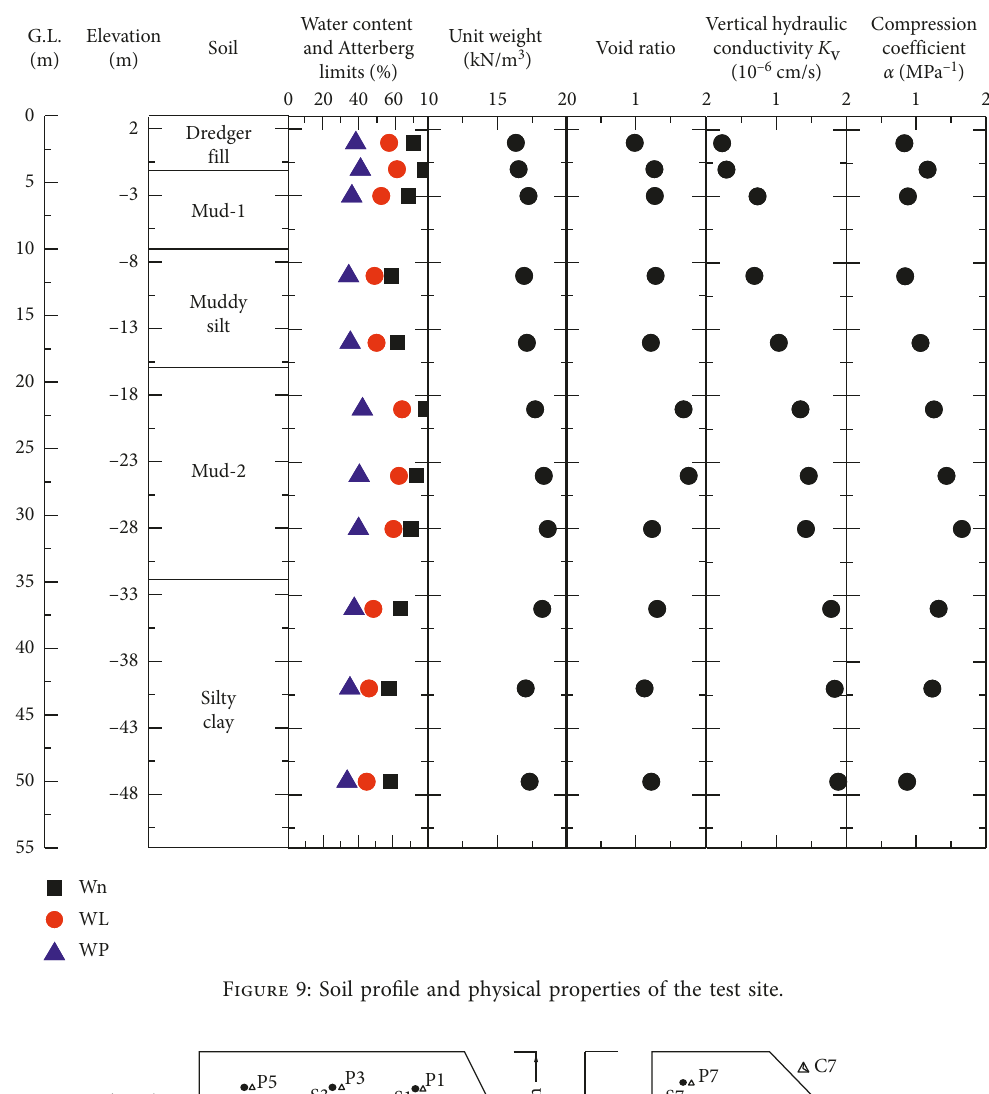
Figure 9: Soil profile and physical properties of the test site.